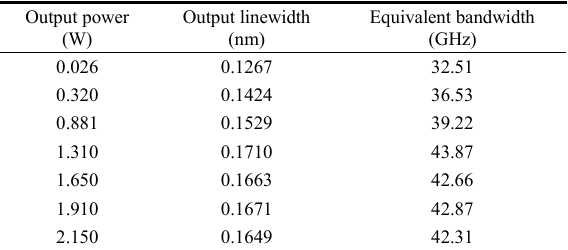
Fig. 5 Spectrum of (a) Output A and (b) Output B with the maximal power. Table 1 Output linewidth and equivalent